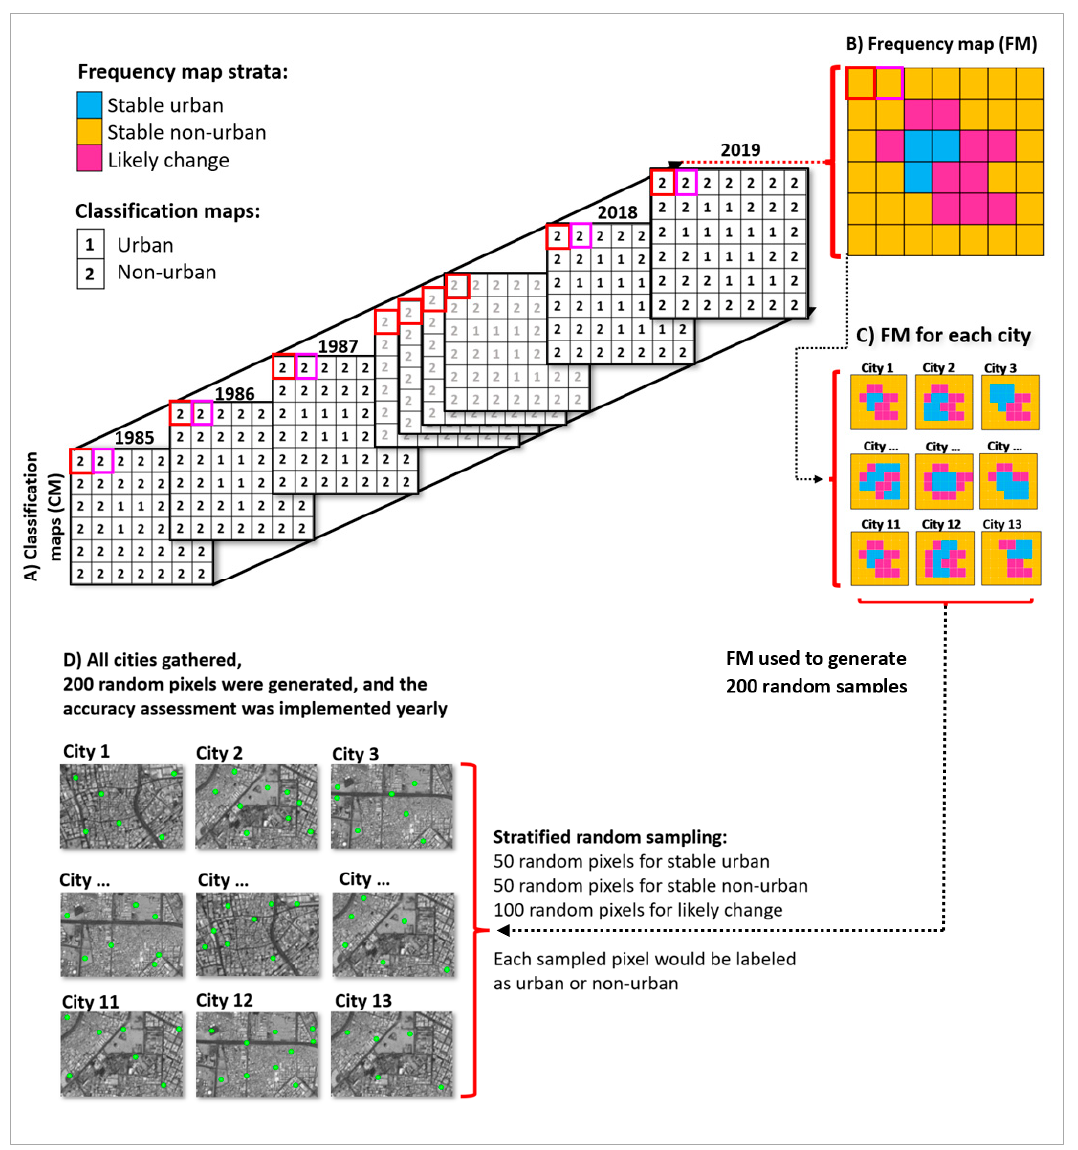
Figure 4. The process of accuracy assessment of the annual classification maps. Note: the green dots represent the random sampled pixels, and the black and white backdrop images represent the Landsat satellite images.